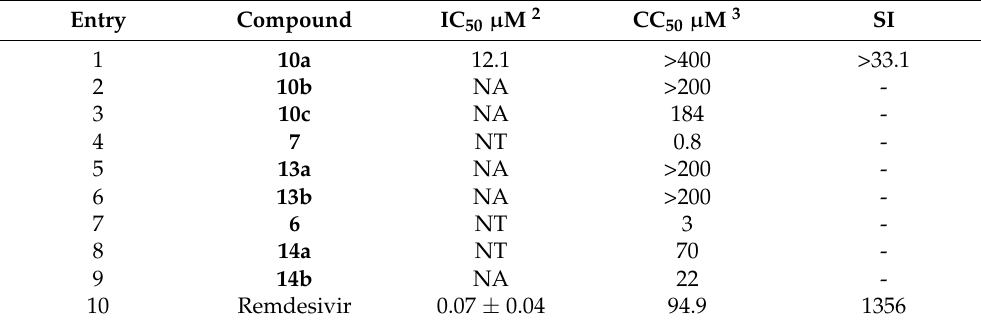
Table 1. Antiviral activity, cytotoxicity, and selectivity index of the synthesized compounds in vitro in a cell-based model 1 .